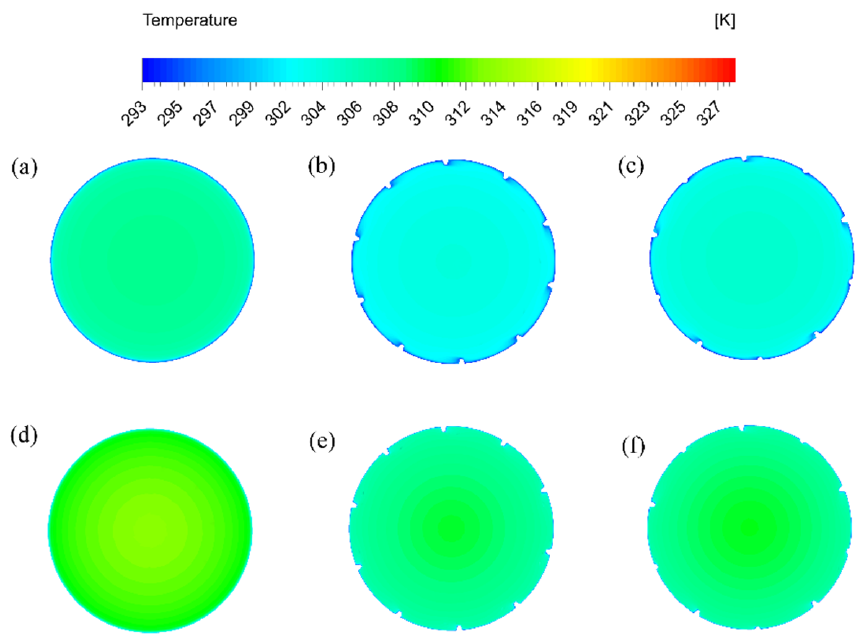
Figure 6. Temperature contours at outlet cross-section ( a ) Smooth tube, Re 12,000; ( b ) Fin-to-Fin height 1:1, Re 12,000; ( c ) Fin-to-Fin height 1:2, Re 12,000; ( d ) Smooth tube, Re 54,000; ( e ) Fin-to-Fin height 1:1, Re 54,000; and, ( f ) Fin-to-Fin height 1:2, Re 54000.